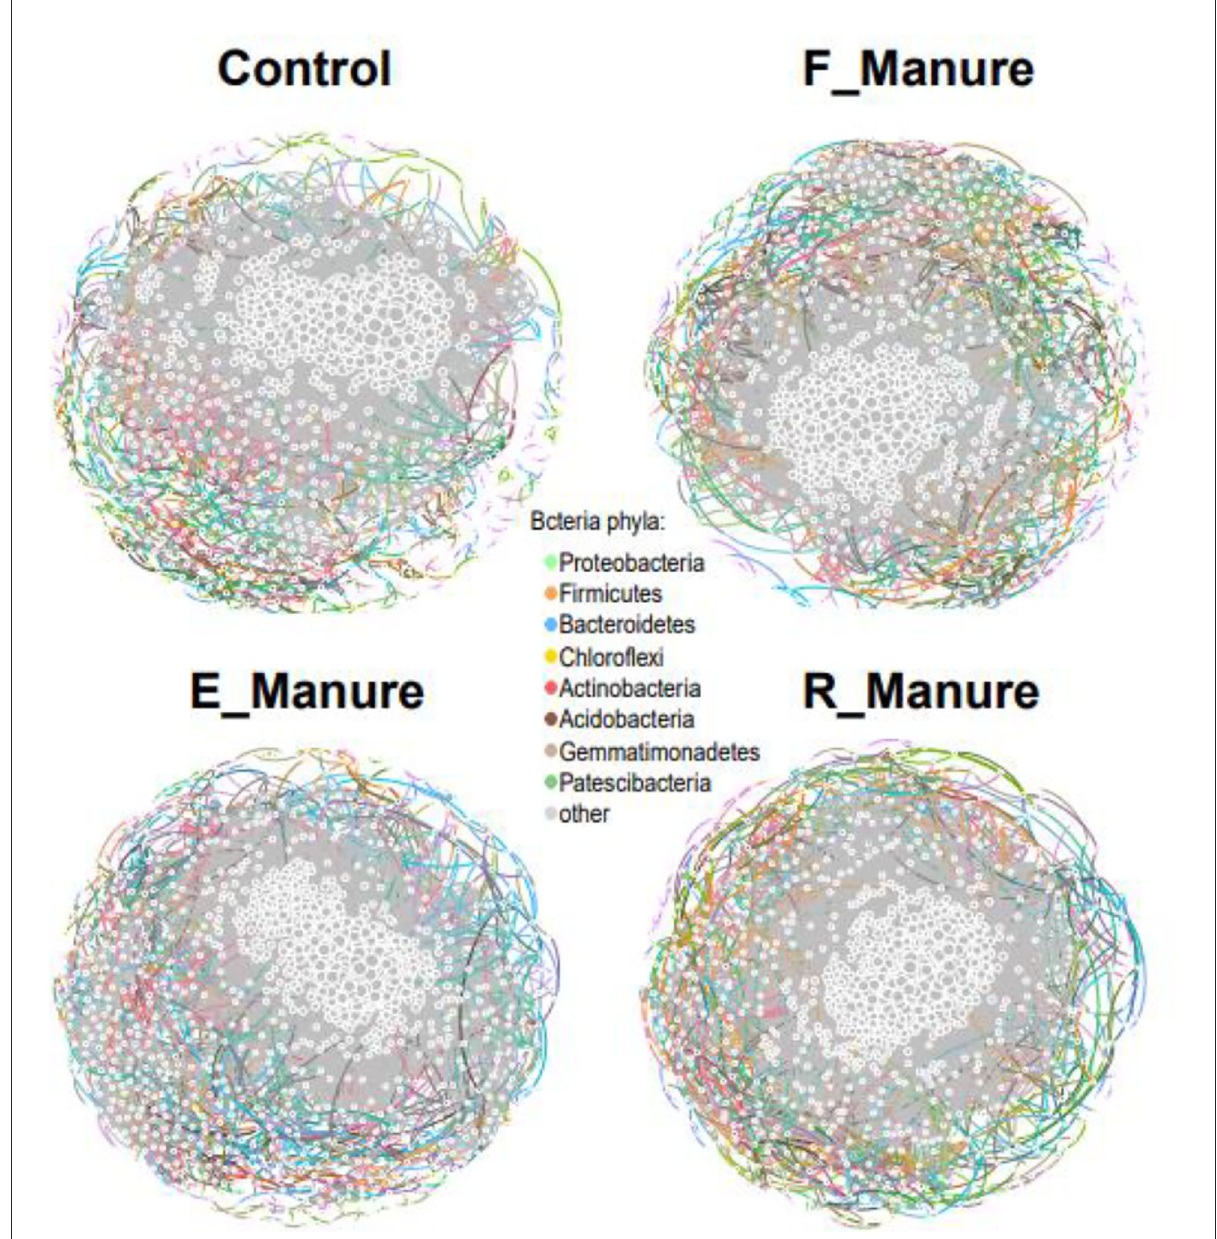
FIGURE6 Co-occurrence networks of each treatment of fertilization. Circles indicate OTUs associated with the network. In particular, the size of circles and triangles is proportional to the number of degrees. OTUs are colored by phylum. The network analysis was visualized using Gephi 0.9.1. Topological properties of the networks of bacterial communities in four different fertilization treatments were shown and others in Supplementary Table